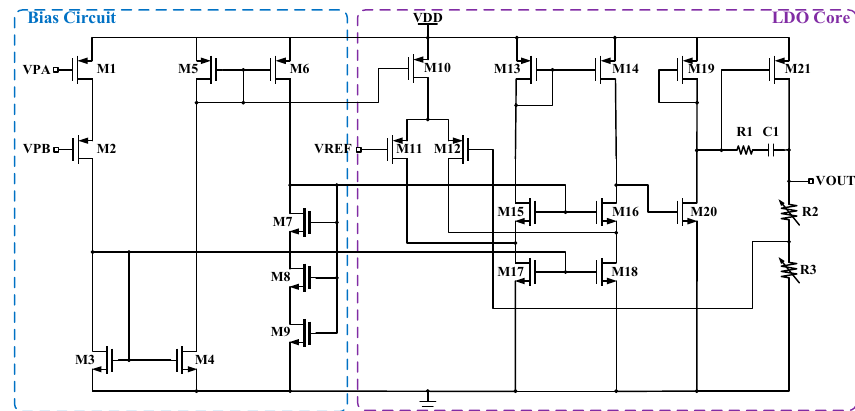
Figure 7. LDO schematic.